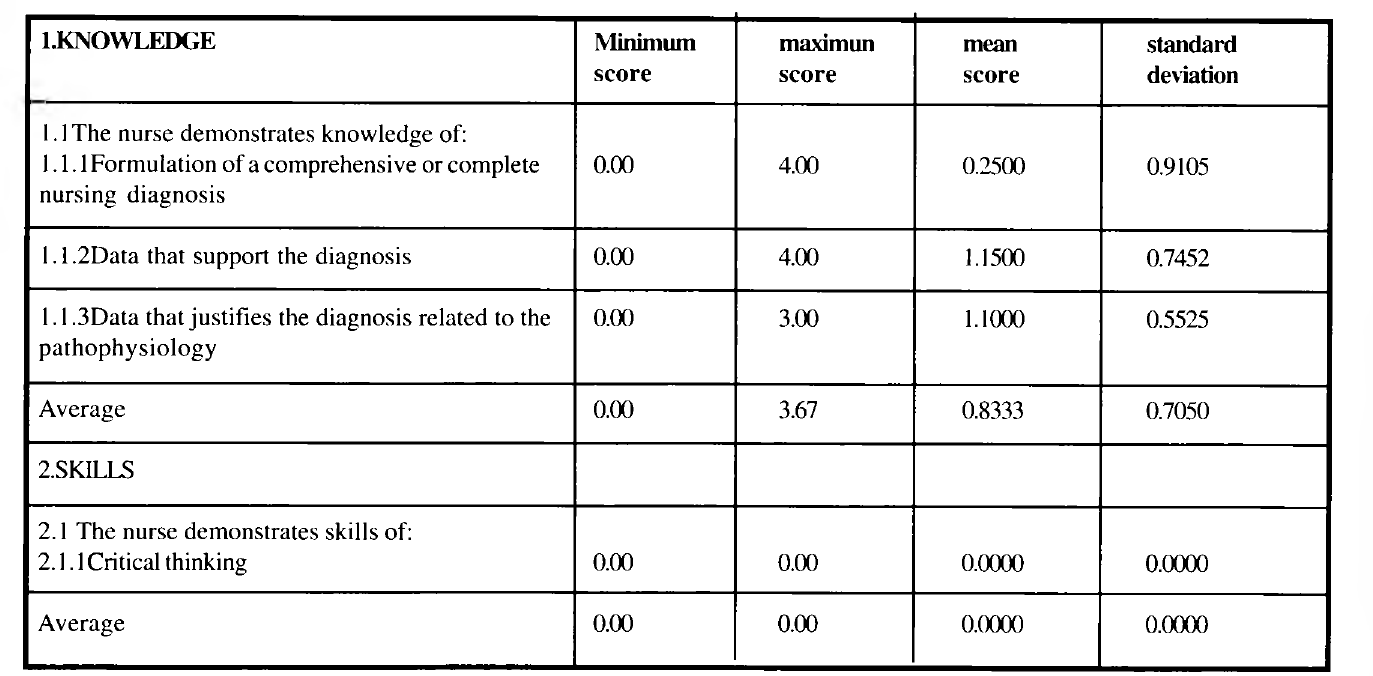
Table 1.3 Scores obtained by participants on the ability to formulate nursing